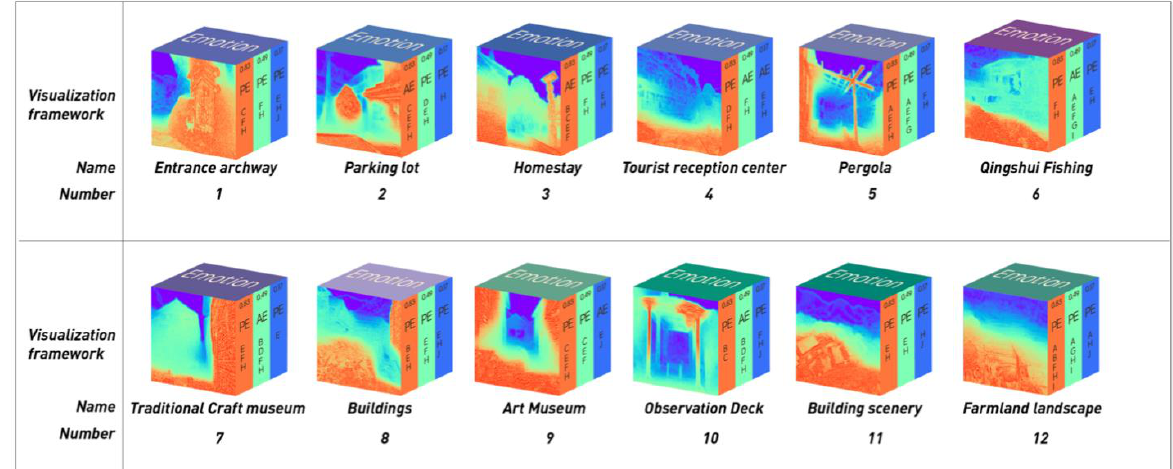
Figure 11. The visualisation of the framework during the whole trip.